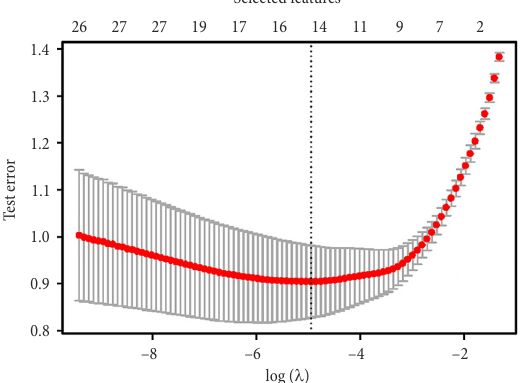
Fig. 3. Cross-validation test error (with 5% confidence intervals) for a range of λ parameter values of the LASSO Method for computing the automatic KEYWORDS